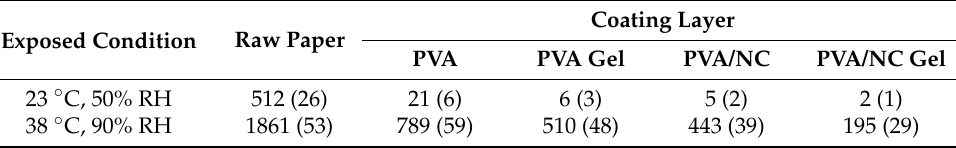
Table 1. Nanoclay addition on WVTR (g/m 2 /d, coating weight: 4 g/m 2 ). Exposed Condition